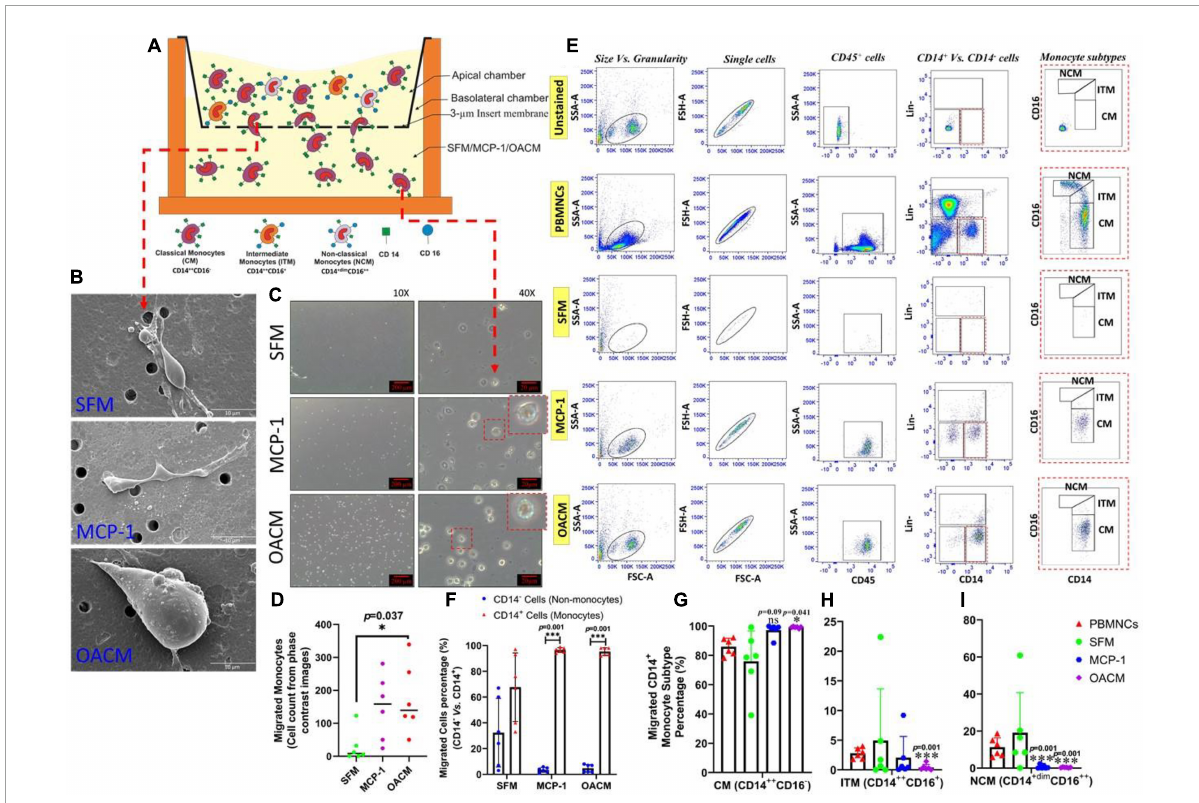
FIGURE5 The migration potential of monocytes in response to SFM, MCP-1, and OACM. (A) Transwell migration model; (B) SEM micrographs of cells on the 3- µ m pores insert membrane at basolateral site (post-migration); (C) Phase contrast photomicrographs of the migrated cells; (D) Enumeration of migrated cells from the phase contrast photomicrographs using Image-J; (E) The gating strategy in FACs analysis using CD45, Lineage negative (Lin-), CD14, and CD16 markers; (F) Percentage count of CD14 + (monocytes) and CD14 − (non-monocytes) gated migrated cell population; (G) Percentage count of migrated classical monocytes (CM: CD14 ++ CD16 − ), (H) intermediate monocytes (ITM: CD14 ++ CD16 + )%; and (I) Non-classical monocytes (NCM: CD14 + dim CD16 ++ ). PBMNCs were used as pre-migration baseline control when compared with migrated monocytes (not significant: ns). The assessments were reported to be statistically significant if * p < 0.05 and *** p < 0.001.